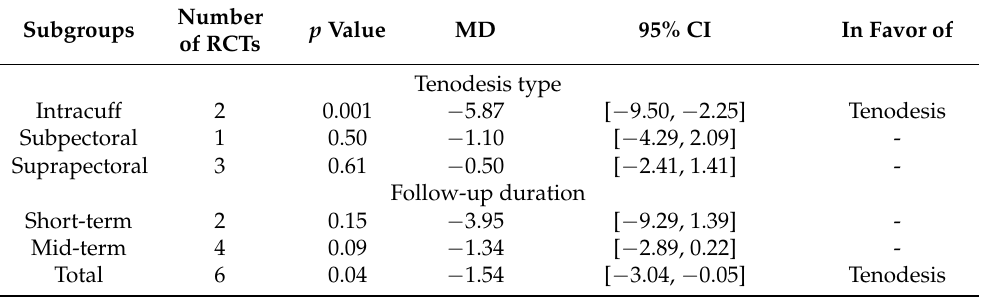
Figure 4. Meta-analysis of randomised controlled trials showing the Constant score improvement from baseline was greater in the patients who underwent tenodesis. Green symbol: mean difference value; Black symbol: result of meta-analysis. Table 3. Summary of subgroup analyses of Constant score improvement. Table 3. Summary of subgroup analyses of Constant score improvement.